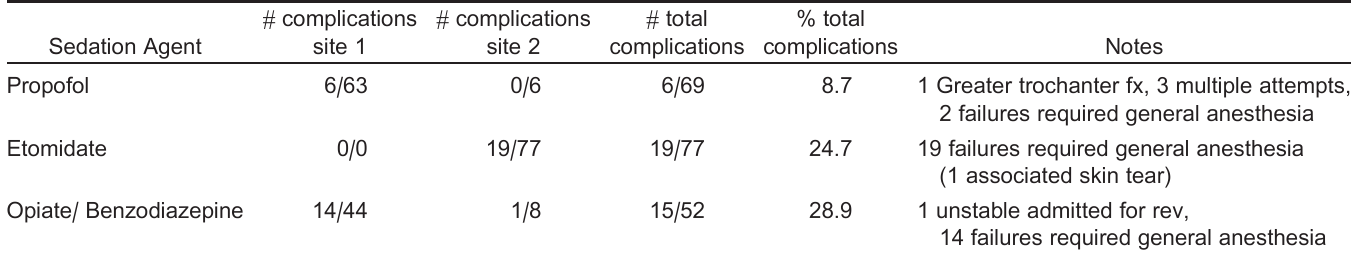
Table 2. Observed hip reduction